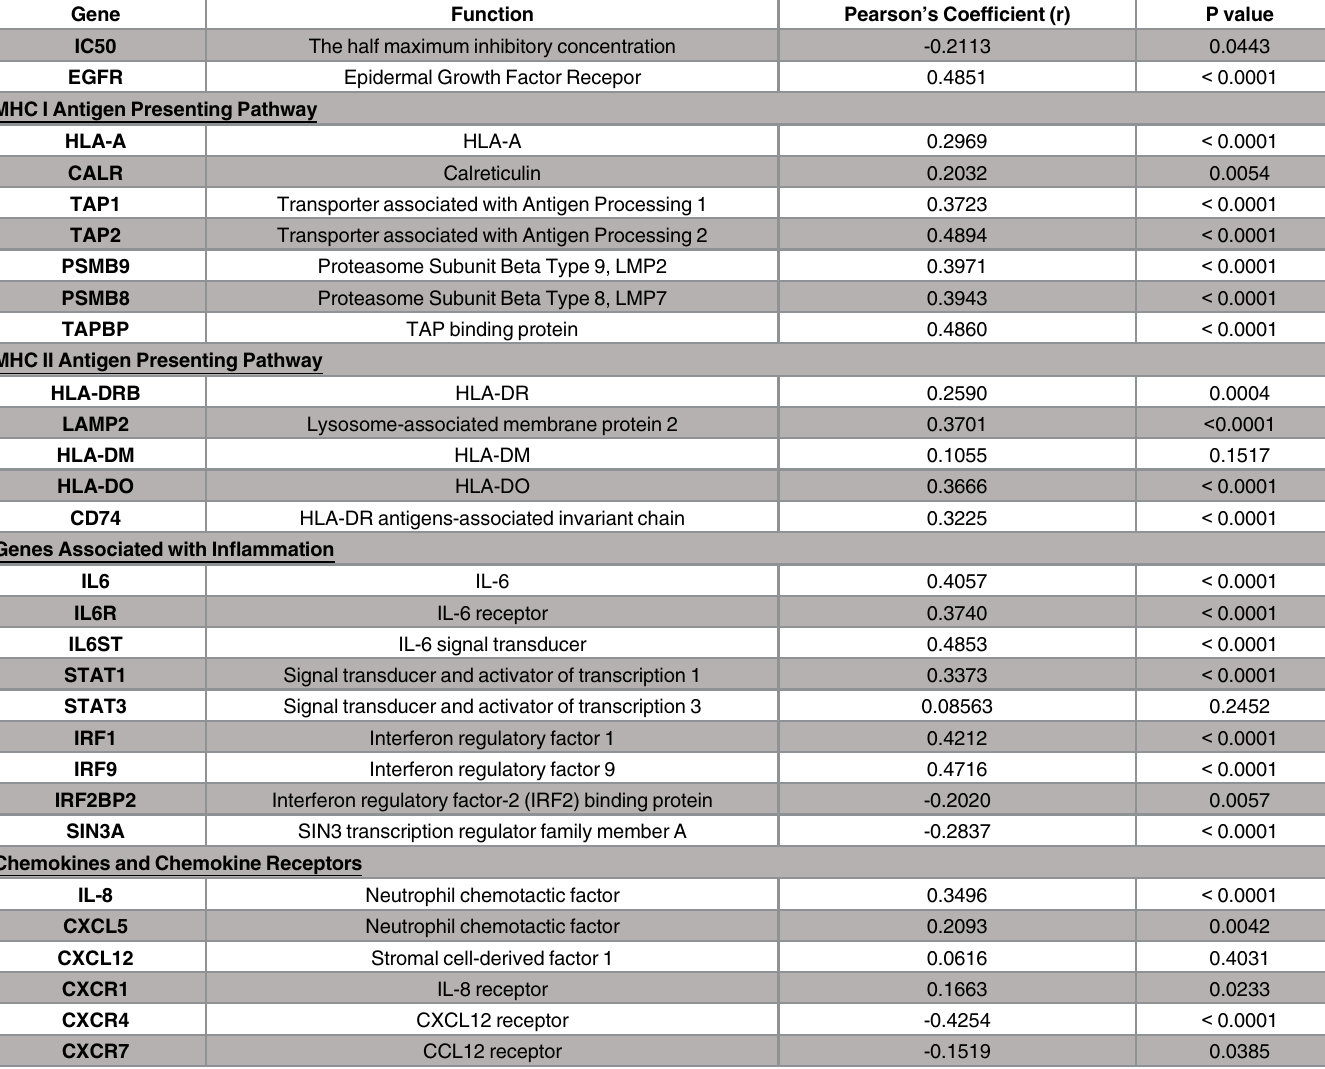
Table 3. The correlation between expression of immune-related genes and PD-L1 of lung cancer cell lines from CCLE.